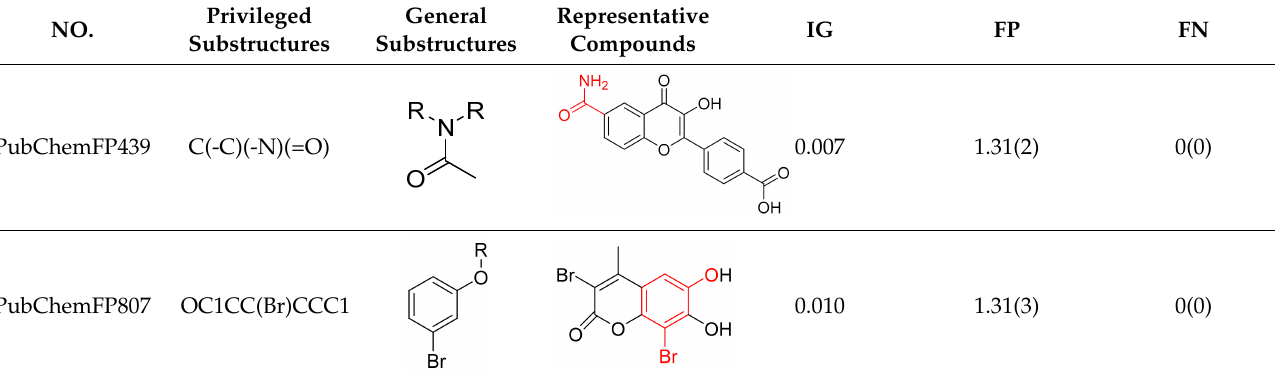
Table 2. PubChem fingerprint-based privileged substructures responsible for CK2 inhibition.